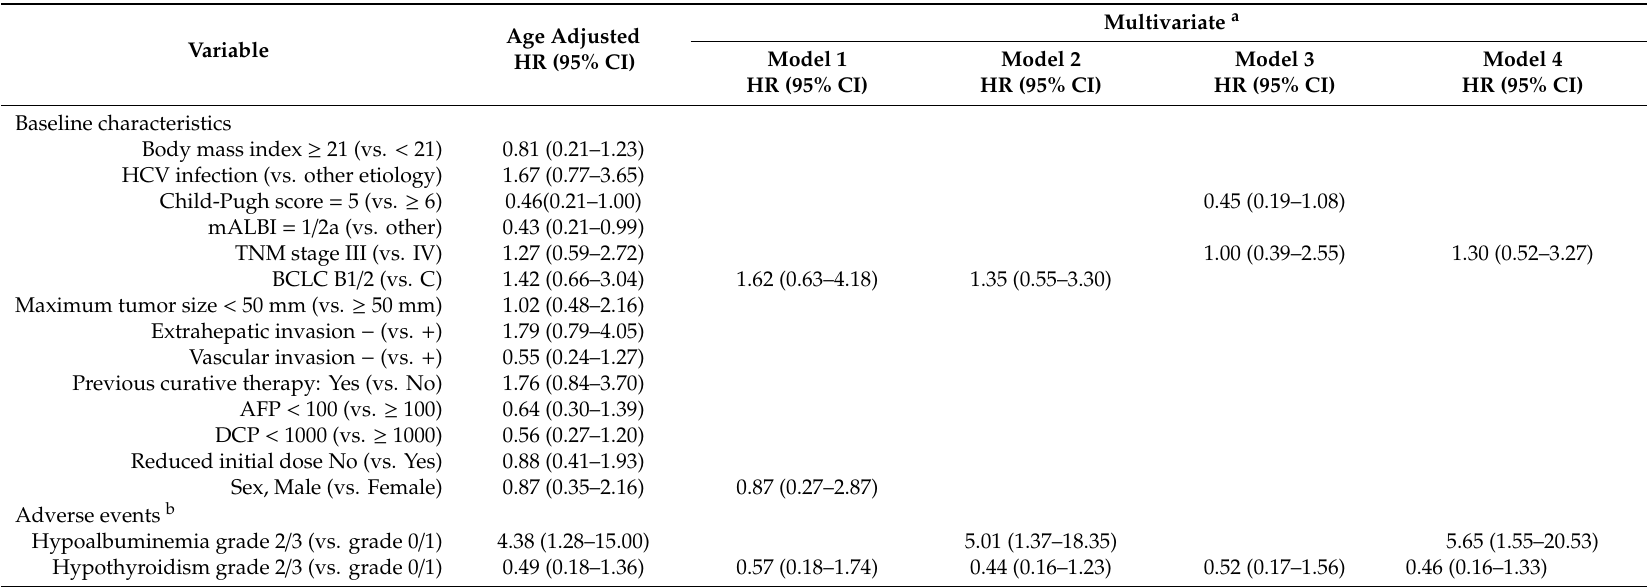
Table 3. Baseline demographic and clinical variables and adverse events associated with treatment